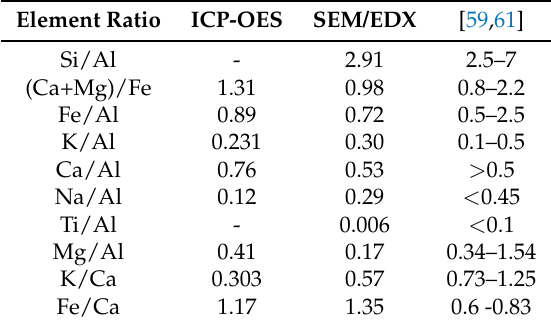
Table 1. Elemental ratios obtained from ICP-OES, SEM/EDX analyses of the collected dust sample and the ratios found in the literature specific for the north African